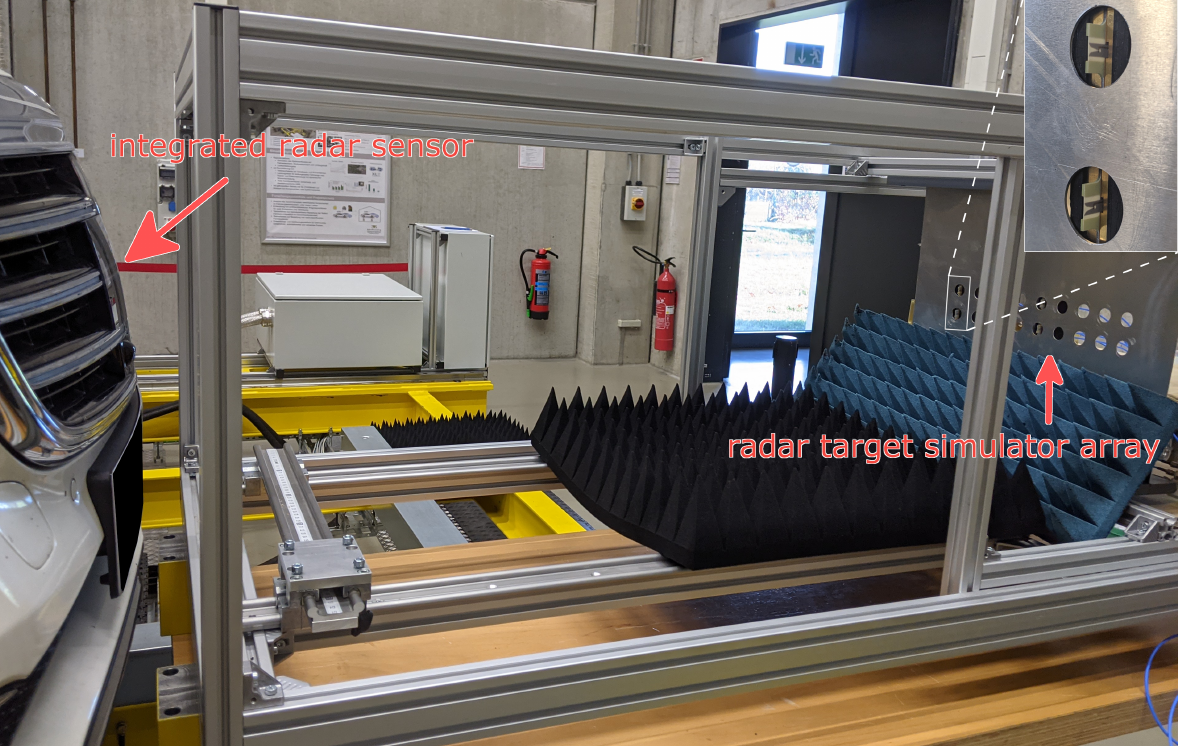
Figure 6. The measurement